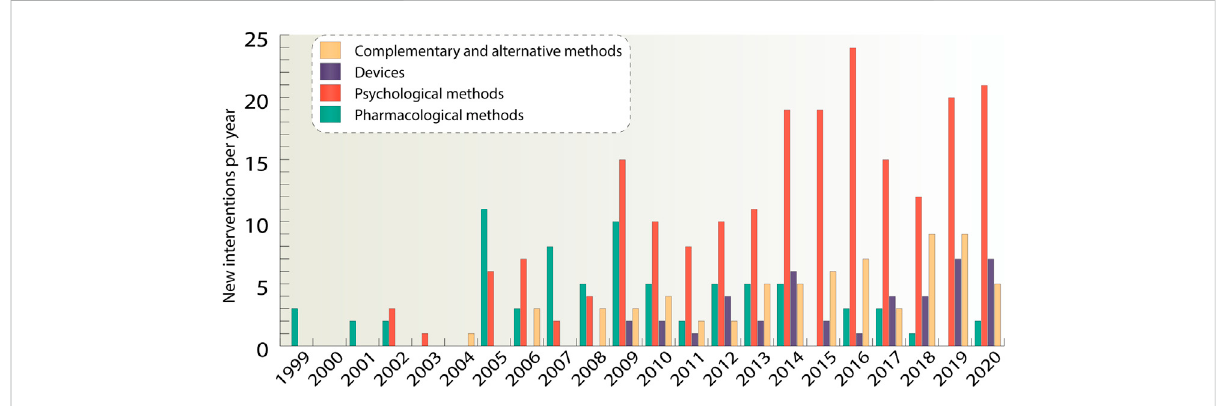
FIGURE 3 For the four main classes of interventions such as pharmacological interventions, devices, psychological and complementary and alternative interventions, unique new agents and methods per year were taken. If a study had several interventions, all of them were considered separately. The data is due 4 January